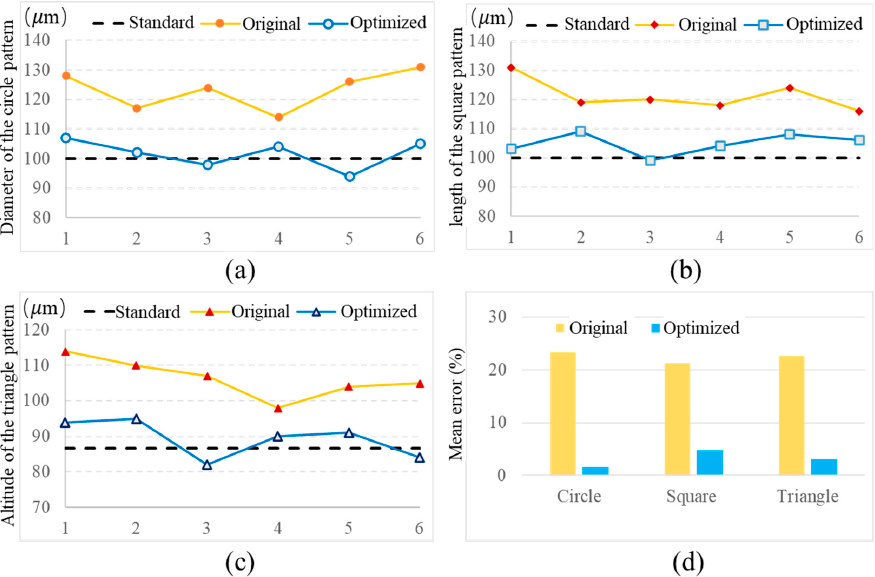
Figure 8. Comparison between the original designed and the optimized structures on dimension accuracy. ( a ) The dimensions of the circle pattern, ( b ) the dimensions for the square pattern, ( c ) the dimensions for the triangle pattern and ( d ) the mean error of each pattern.